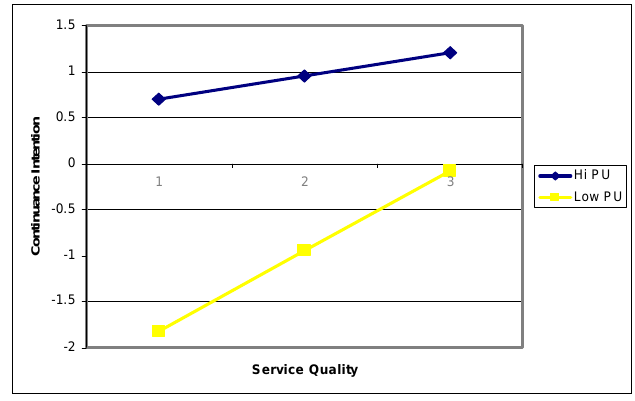
Figure 2: Plot of the service quality - perceived usefulness interaction